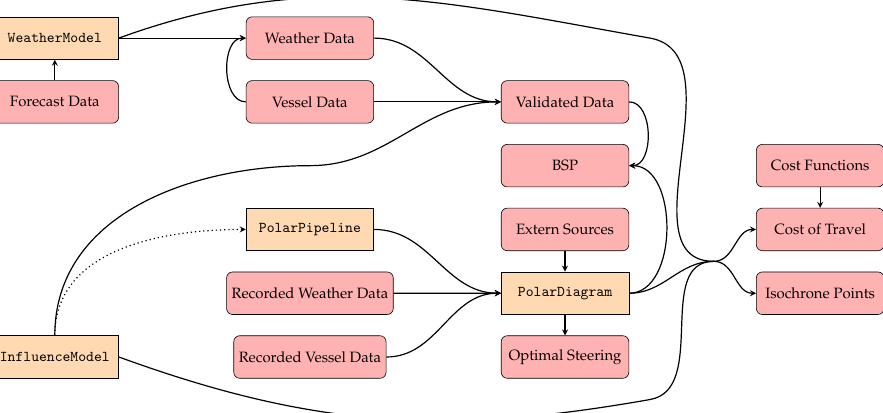
Figure 6. A visual representation of the hrosailing framework. Red boxes with rounded corners indicate data, yellow boxes indicate framework components. Solid arrows from multiple objects to a single indicate the possibility to compute the object at the end by using the objects at the starting points. Dashed arrows indicate the “part of”